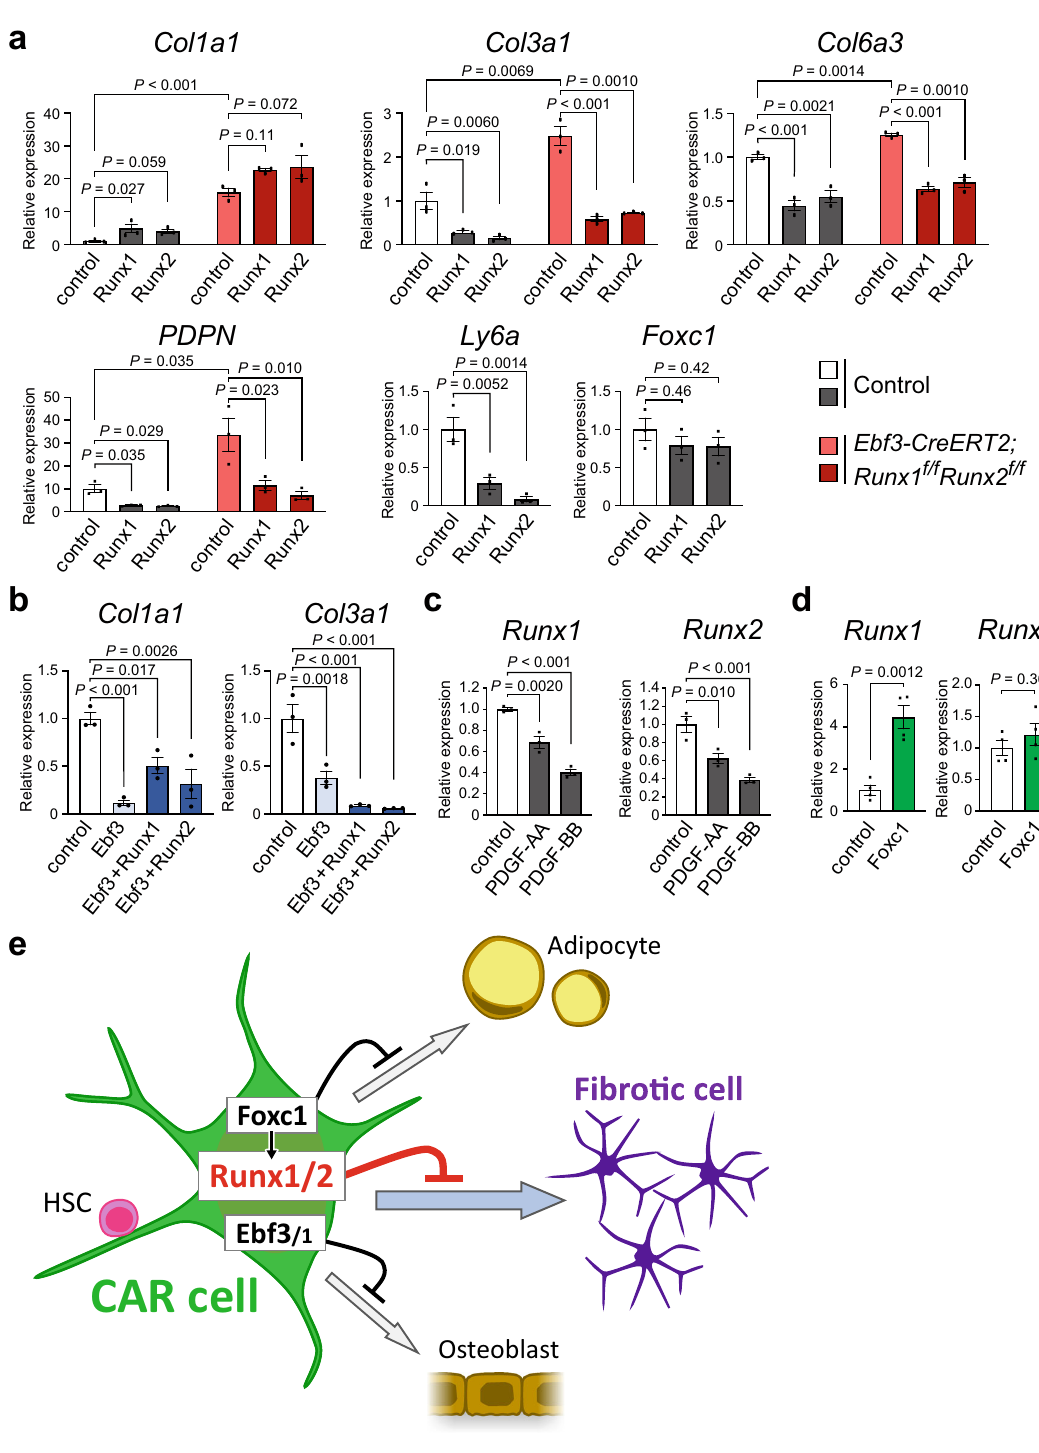
Fig. 5 In vitro activities of Runx1 or Runx2 on fi brotic gene expression in CAR cells. a Analysis of CAR cells from control and tamoxifen-treated Ebf3- CreERT2;Runx1 f/f Runx2 f/f mice transduced with retroviruses expressing Runx1 and Runx2 as well as empty vector in vitro. Relative mRNA expression levels of Col1a1 , Col3a1 , Col6a3 , PDPN , Sca-1 ( Ly6a ) and Foxc1 in infected CAR cells cultured for 4 days ( n = 3 biological replicates per group). b Analysis of CAR cells from wild-type mice transduced with retroviruses expressing Ebf3 , Ebf3 and Runx1 , or Ebf3 and Runx2 as well as empty vector in vitro. Relative mRNA expression levels of Col3a1 and Col6a3 in infected CAR cells cultured for 4 days ( n = 3 biological replicates per group). c Effects of PDGFs on Runx1 and Runx2 expression in CAR cells in vitro. Relative mRNA expression levels of Runx1 and Runx2 in CAR cells cultured in the presence of PDGF-AA or PDGF-BB for 3 days ( n = 3 biological replicates per group). d Analysis of CAR cells transduced with retroviruses expressing Foxc1 and empty vector in vitro. Relative mRNA expression levels of Runx1 and Runx2 in infected CAR cells cultured for 4 days ( n = 3 biological replicates per group). e Working model. CAR cells are specialized mesenchymal stem cells, which express the speci fi c transcription factors, including Runx1/2 as well as Foxc1 and Ebf1/3. Runx1/2 prevents fi brotic conversion of CAR cells to maintain HSC niches. All error bars represent SD of the mean. Statistical signi fi cances were calculated using one-way ANOVA with Dunnett ’ s test ( a – c ) and the two-tailed unpaired Student ’ s t -test ( d ). Source data are provided as a Source Data fi